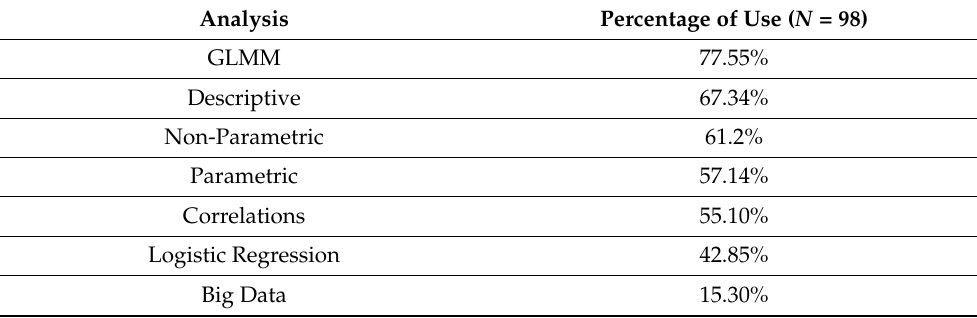
Table 4. Most frequent type of statistical analysis conducted by Ethology researchers ( N =